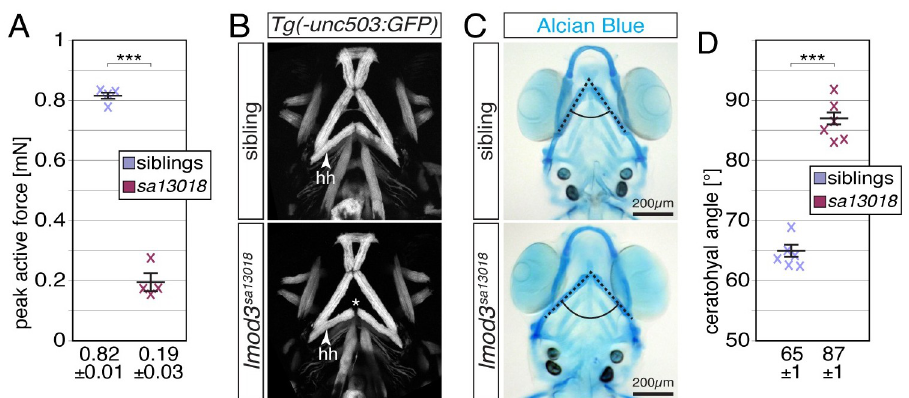
Fig 2. Lmod3-deficiency leads to weakening of the trunk and head musculature. (A) Peak active force of single- twitch contractions generated by 6-dpf-old individual lmod3 sa13018 larvae was significantly weaker compared to their siblings. Siblings generated a maximal active force of 0.82 ± 0.01 mN, compared to and 0.19 ± 0.03 mN generated by lmod3 sa13018 homozygotes (n = 4). (B) Z-stack projections of ventral views depict the cephalic musculature marked by GFP driven by the Tg(−503unc : GFP) transgene. In contrast to 4-dpf-old siblings, a gap between the two hyohyoideus (hh) muscles was formed in the lower jaw of lmod3 sa13018 homozygotes (asterix). (C) At 7dpf, focus stacks of Alcian Blue cartilage stains revealed a widened jaw within lmod3 sa13018 mutants. (D) The angle formed by the ceratohyal cartilages (dotted lines) was significantly wider in lmod3 sa13018 homozygotes compared to siblings (87 ± 2˚ and 65 ± 1˚, respectively. n = 6). Data are presented as mean ± SEM; ��� P < 0.001 calculated by Student’s t test. Scale bar sizes are 200 μ